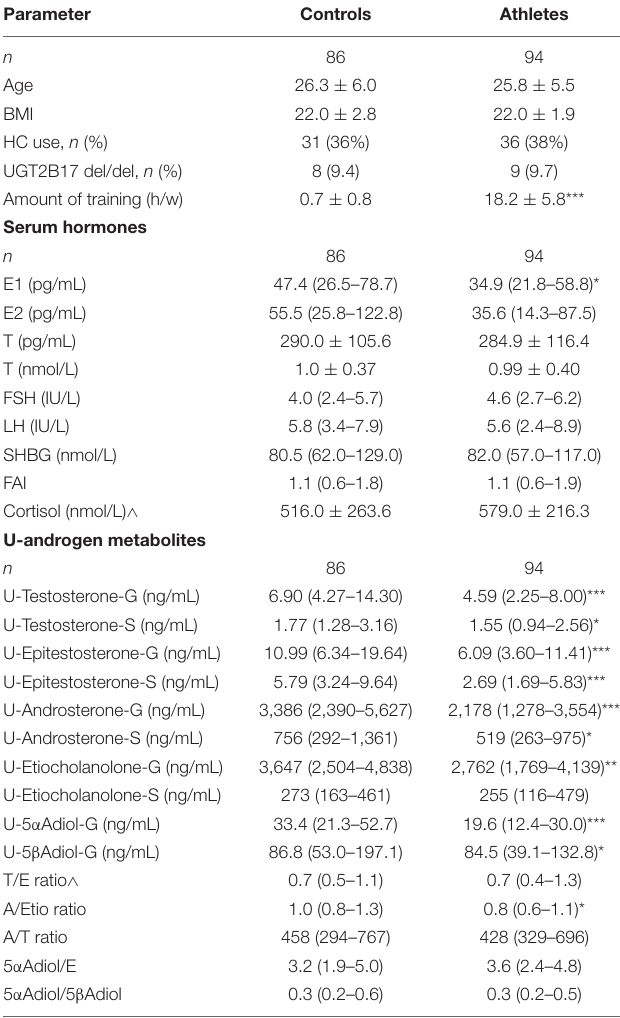
TABLE 1 | General characteristics, serum hormones and urinary androgen metabolites in female Olympic athletes and